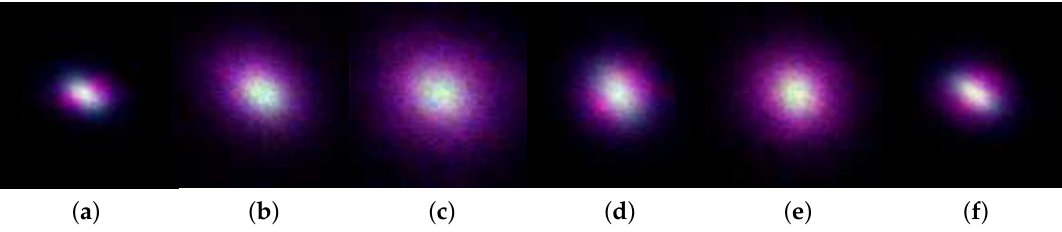
Figure 7. Images of bearing fault data. ( a ) Contaminant, ( b ) outer high, ( c ) outer medium, ( d ) outer low, ( e ) inner high, and ( f ) inner medium.